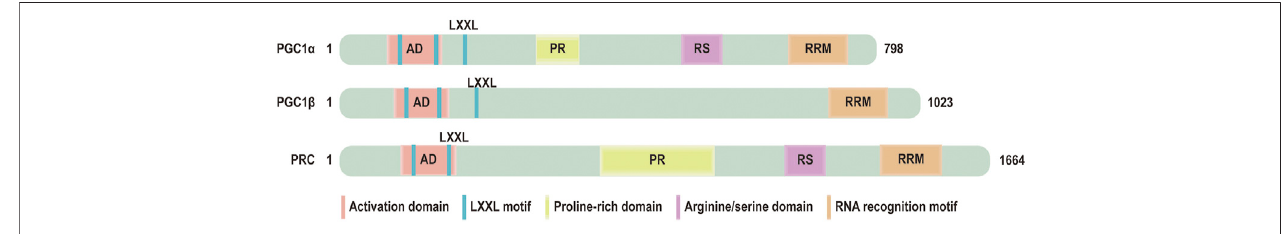
FIGURE 1 | Domain structure of PGC-1 coactivators: the functional domains of PGC-1 coactivators: activation domain (AD), LXXL motif, a proline-rich domain, arginine/serine (RS) domain, RNA recognition motif (RRM).